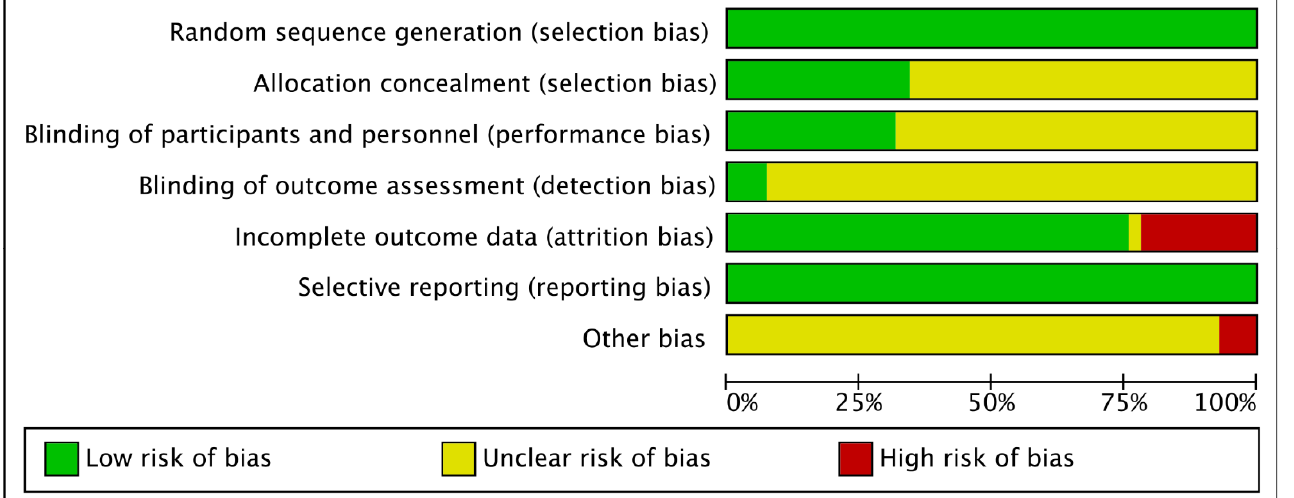
Figure 2. Risk of bias graph.